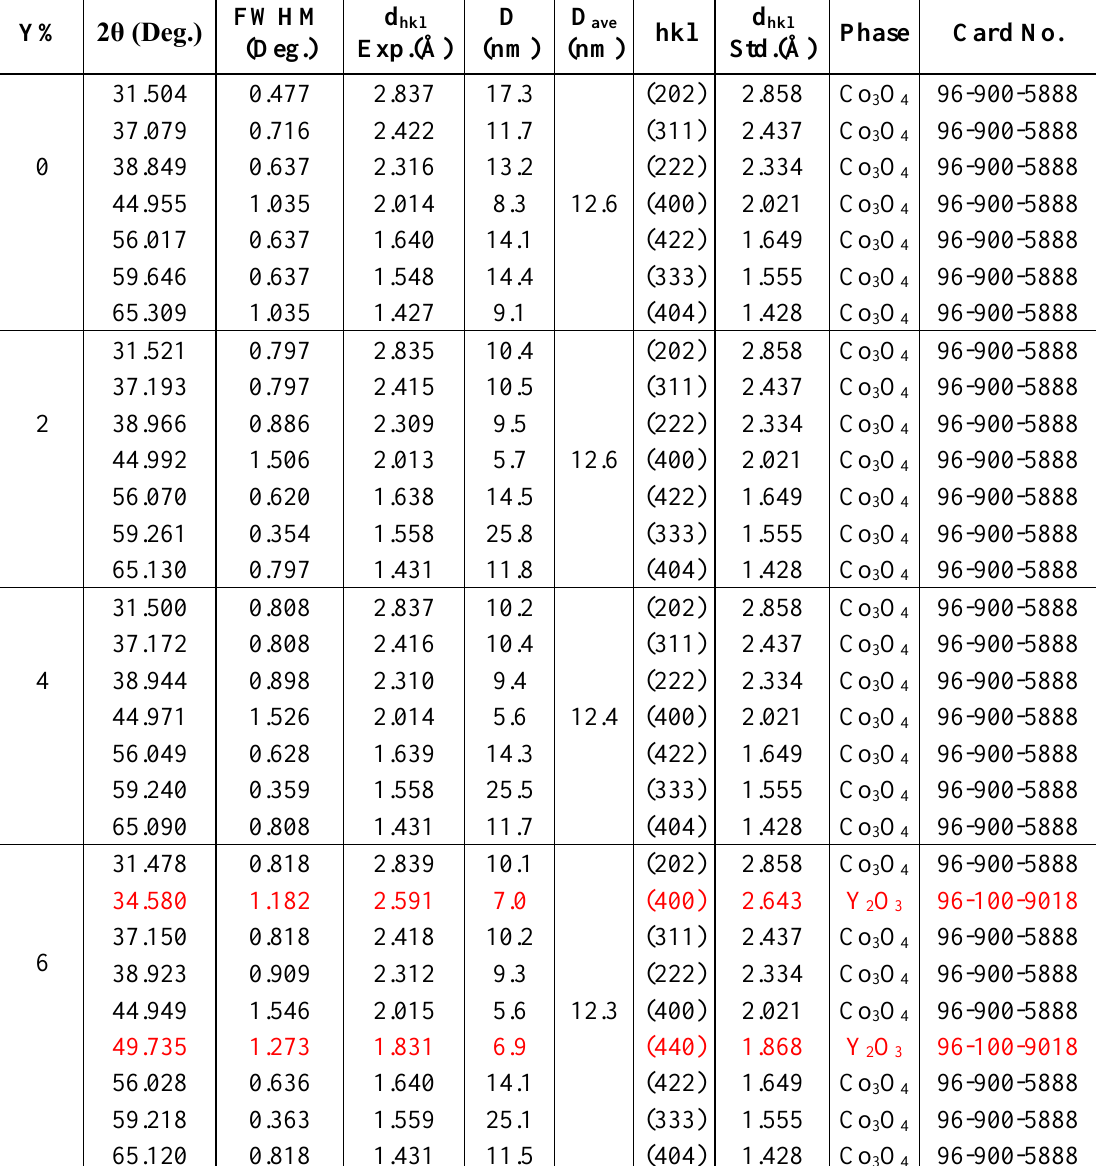
Table 1: Structrure Parameters for for undoped Co of yttria thin films deposited on n-Si substrate by hydrothermal method.